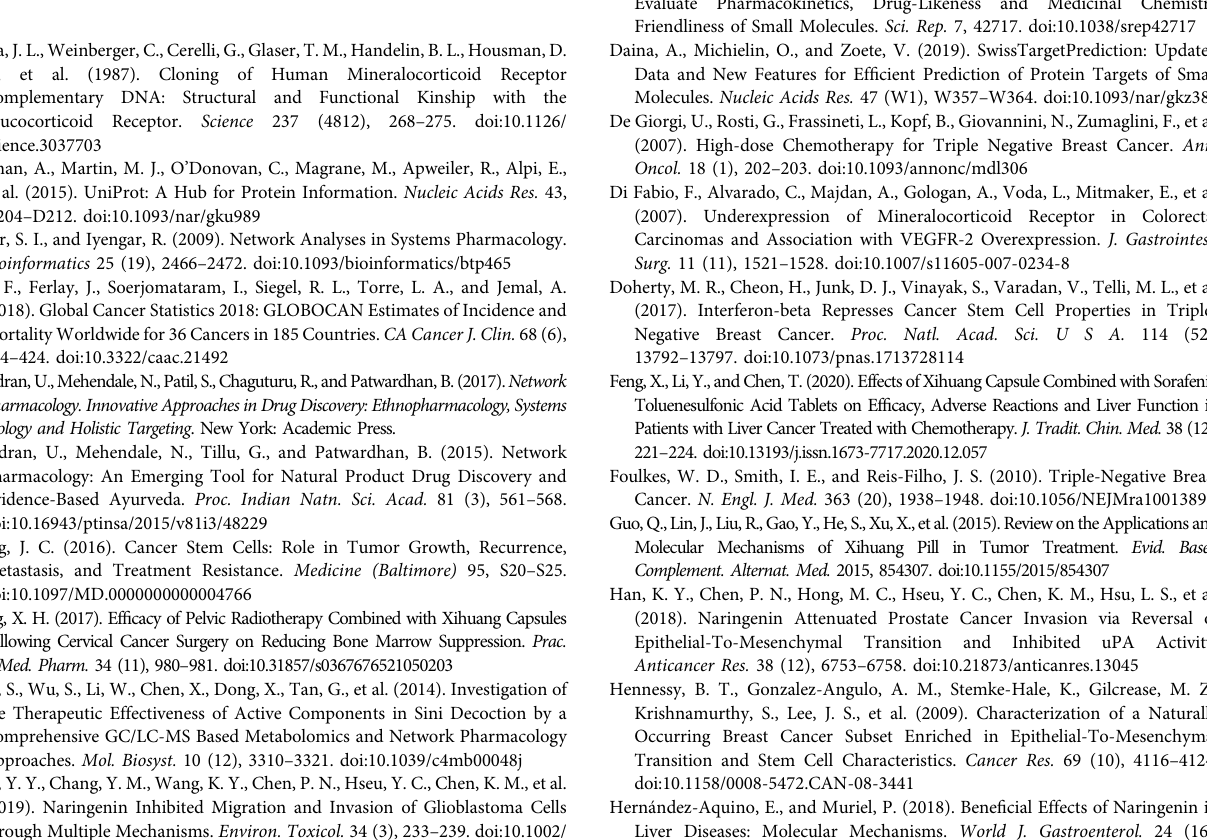
SUPPLEMENTARY FIGURE S1 | Enrichment analysis of the 190 overlapping target genes. (A) Bar graph of the 15 most signi fi cant of gene ontology. Green, biological process; blue, cellular component; and red, molecular function. (B) Bubble diagram of the KEGG enrichment analysis. Y-axis label represents